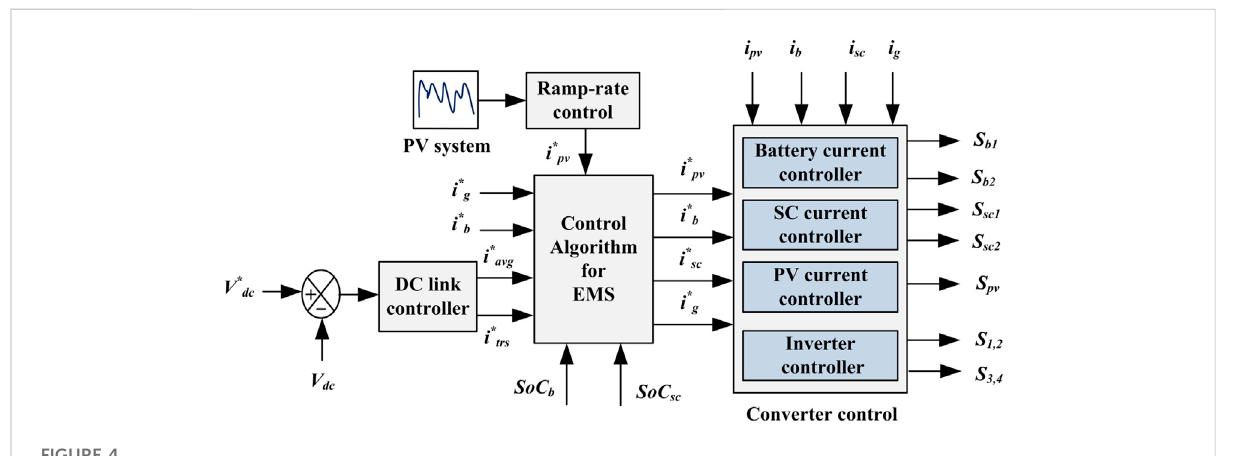
FIGURE 4 Simpli fi ed control of a proposed system.